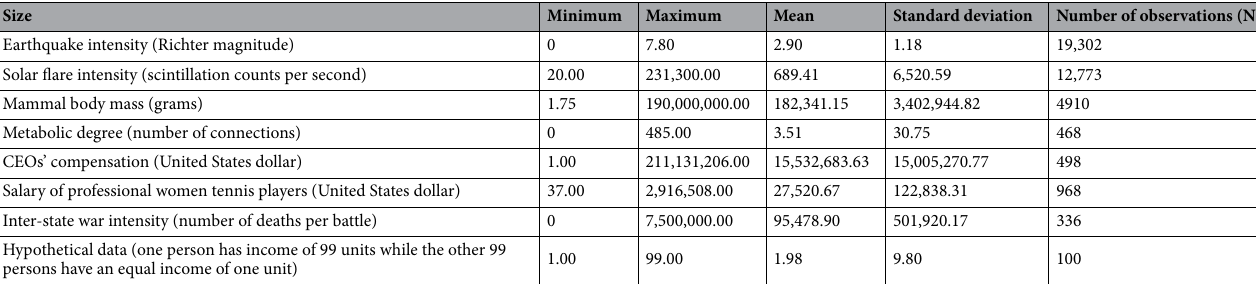
Table 2. The descriptive statistics of the empirical data on sizes of events or things occurring in nature and society and the hypothetical data.